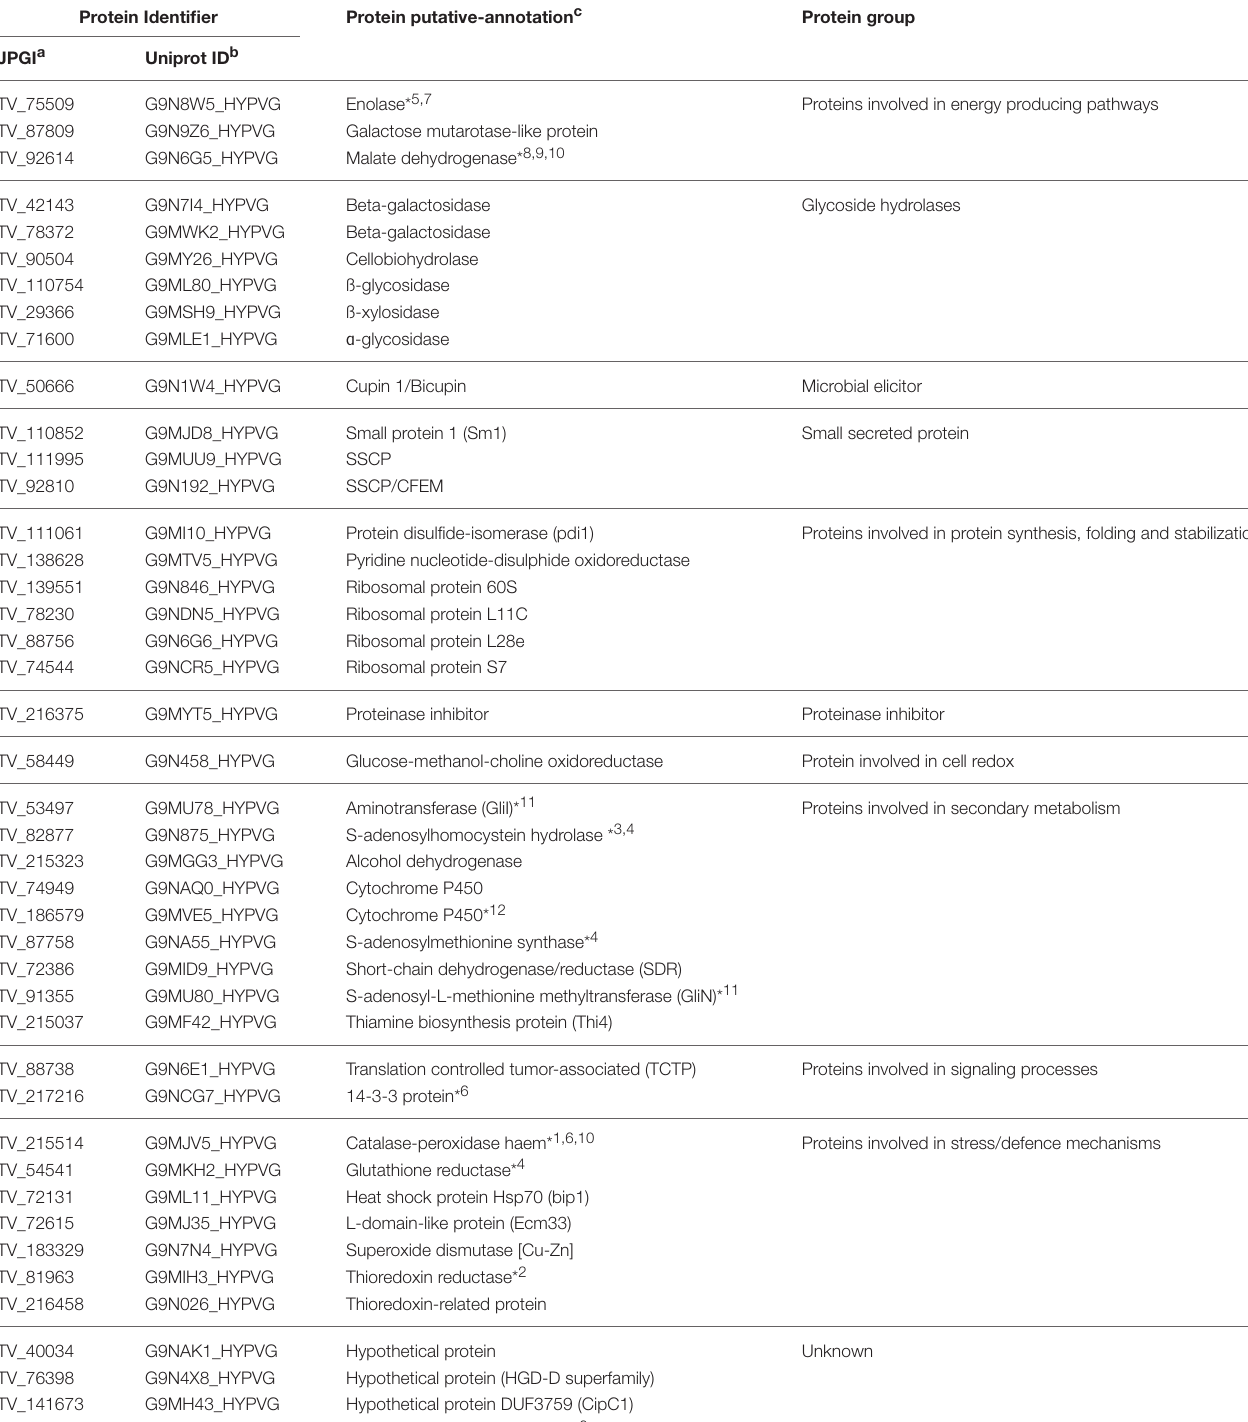
TABLE 2 | Summary of the apoplastic proteins secreted by Trichoderma virens after 5 days interaction. Protein